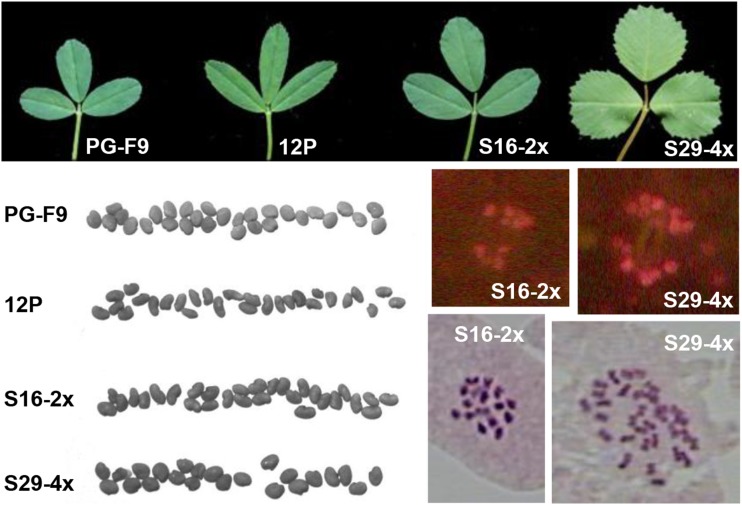
Determination of the ploidy state of 2x and 4x progeny plants (one plant per ploidy state is shown as an example). In 4x plants, leaf size is larger, and leaflets shape are less elongated, seeds are bigger, and the number of chloroplasts in stomata guard cells is higher (for example, S16-2x, 8 chloroplasts; S29-4x, 13 chloroplasts) than in 2x plants. Root tip cell chromosomes counts (for example, S16-2x, 16 chromosomes; S29-4x, 32 chromosomes) confirmed the ploidy estimation based on morphological traits (see text for details).